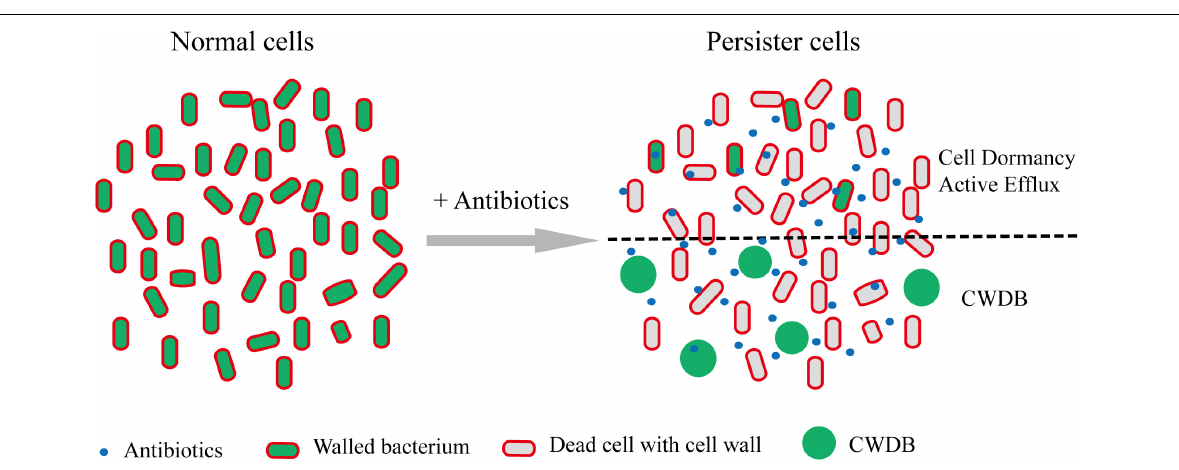
FIGURE 3 | Persisters formation through CWDB. Upon antibiotic treatment, a portion of persisters maintain intact cellular structure through forming dormancy and/or active efflux pumps. In addition, some bacteria could survive after their cell walls being damaged and form spheroplast or L-form. Through an unknown mechanism, such bacteria could persist in vivo or in vitro . Persister cells with intact cell structure or cell wall deficiency are separated by black dot